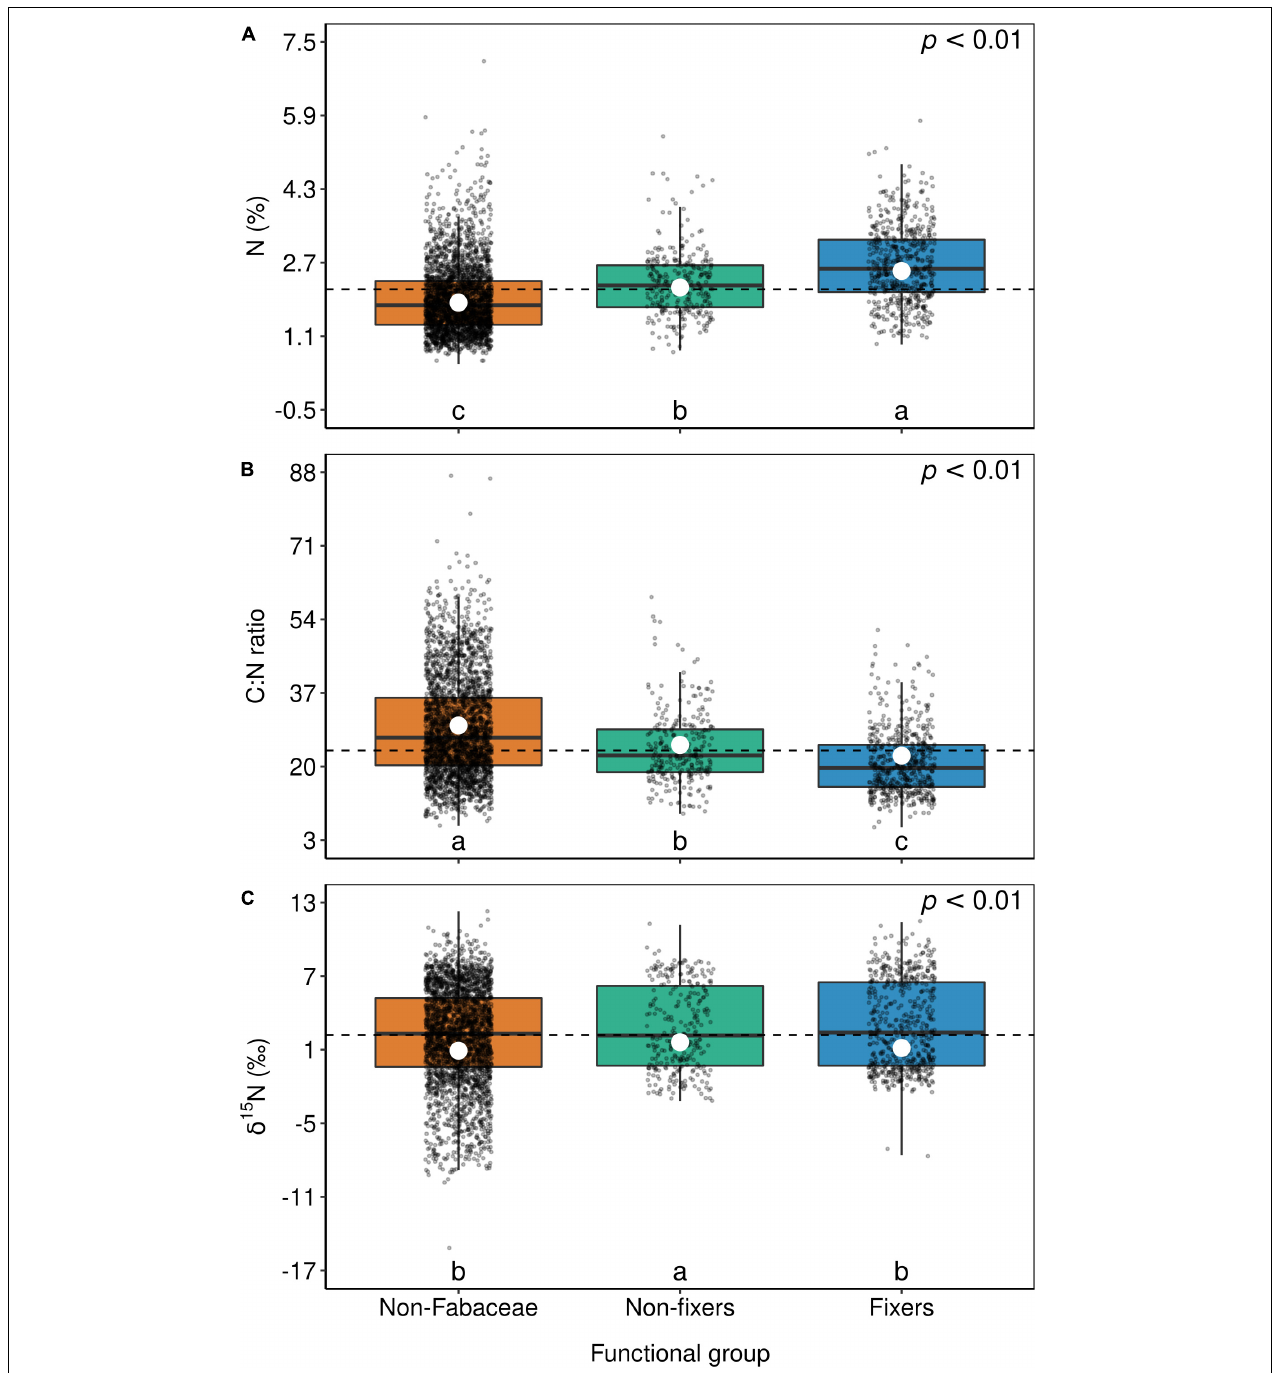
FIGURE 6 | Box-plots of foliar N (A) , C:N ratio (B) , and δ 15 N (C) of non-Fabaceae species as well as non-fixer and N 2 -fixer species of the Fabaceae family. The horizontal lines inside each box represent the median; the box represents the first and third quartiles; and the bars represent the interquartile range. The horizontal dashed line represents the mean of the entire population. White circles represent estimate means obtained from the generalized linear mixed model. The summary of the statistical model can be seen in Supplementary Table 1 . Levels followed by a common letter are not different according to the Sidak-test at p ≤ 0.05.